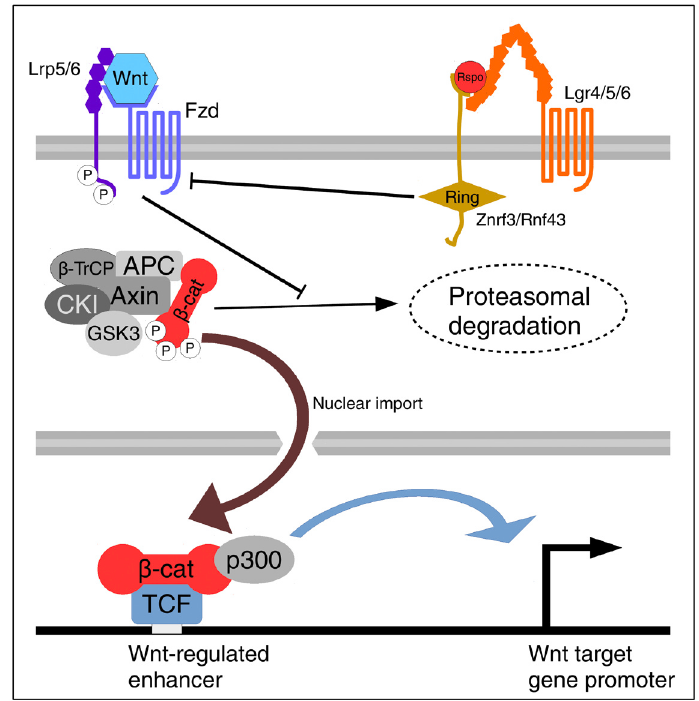
Figure 1. Overview of vertebrate Wnt/ β -catenin (Wnt/ β -cat) signaling. Wnt binding to Frizzled (Fzd) and low-density lipoprotein receptor- related protein 5/6 (Lrp5/6) co-receptors promotes the phosphorylation of Lrp5/6’s cytoplasmic tail. These interactions block the ability of the destruction complex to phosphorylate and ubiquitinate β -cat, preventing its degradation by the proteasome. Stabilized β -cat enters the nucleus, where it is recruited to Wnt-regulated enhancers by transcription factors (TFs) of the T-cell factor (TCF) family. R-spondin (Rspo) potentiates Wnt/ β -cat signaling by increasing the number of Fzd receptors. Rspo forms a complex with Lgr4/5/6 and zinc and ring finger 3 (Znrf3)/ring finger protein 43 (Rnf43), preventing the latter from ubiquitinating Fzd receptors. APC, adenomatous polyposis coli; CKI, casein kinase I; GSK3, glycogen synthase kinase 3; β -TrCP, β -transducin repeat-containing E3 ubiquitin protein